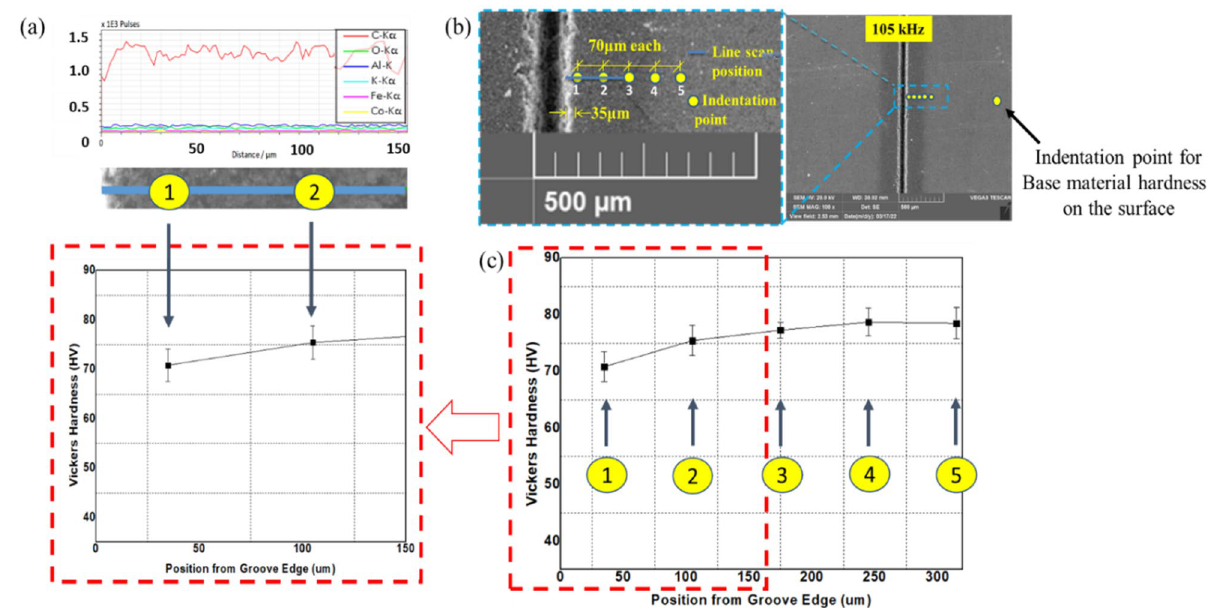
Figure 16. Chemical and hardness tests on surface—105 kHz; ( a ) EDX line scan ( b ) measurement configuration ( c ) Vickers